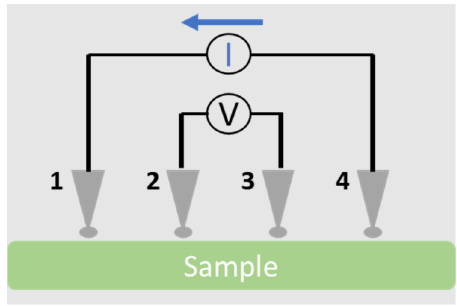
Figure 1. Schematic drawing of a four-point probe tool.